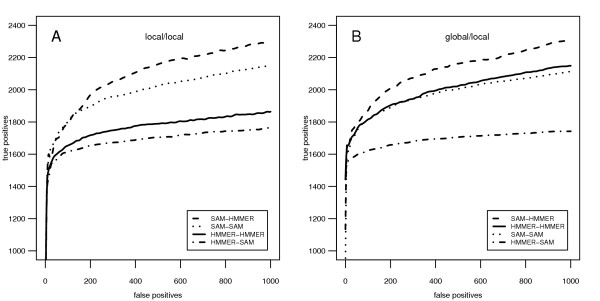
Model building and database searching performance of SAM and HMMER. (A) Local/local mode. (B) Global/local mode. The Viterbi algorithm was used for all searches. Otherwise, default settings were used. The model building program is mentioned first in the legend, and the scoring program second. 'SAM-SAM' means 'Building the HMM using SAM; Searching using SAM', 'HMMER-SAM' means 'Building the HMMs using HMMER; Searching using SAM', etc.